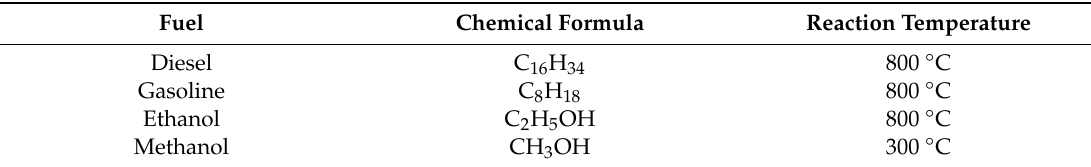
Table 2. Temperature for reforming